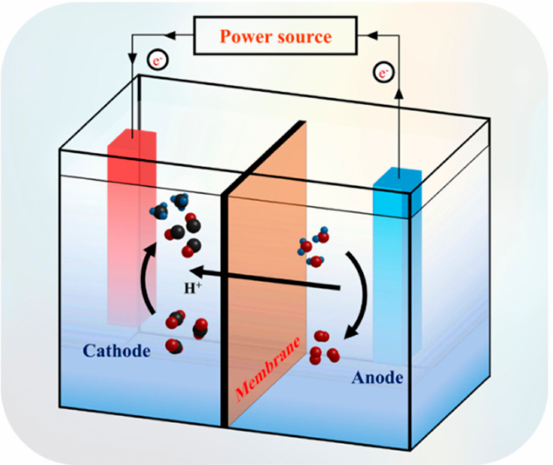
Figure 1. Schematic diagram showing the illustration of CO 2 reduction to chemical fuels using an electrochemical